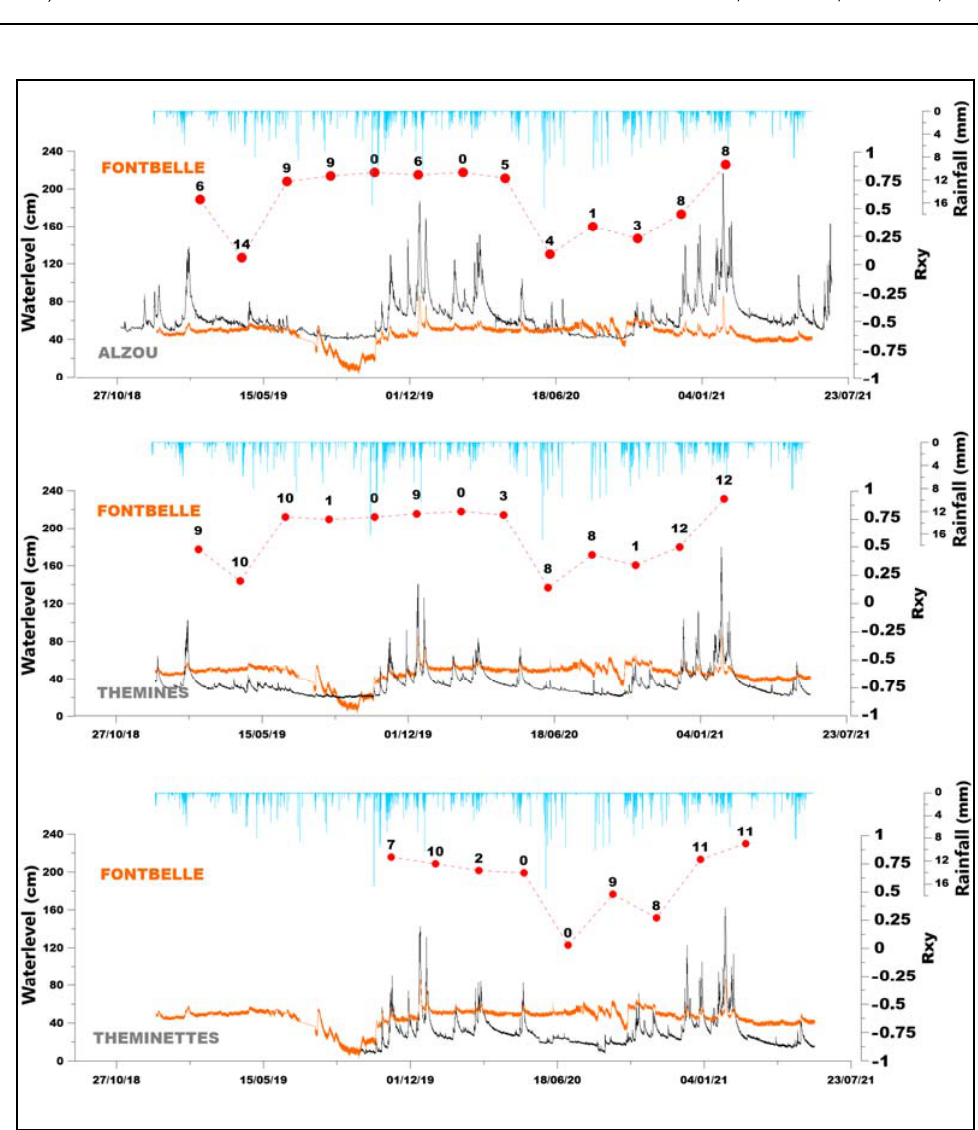
Figure 4. Sliding correlation analyses between the water levels for the Fontbelle station and the different stations at the sinks; the results of the sliding cross-correlation analyses are displayed in red dots (vertical axis: correlation, label: the time lag between the two sites in hours).